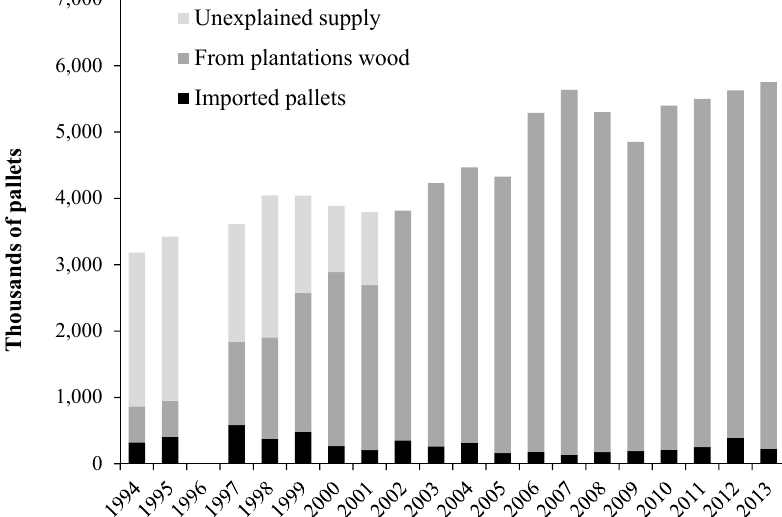
Figure 3. Best guess estimates of the contribution of the different sources of pallets and wood to the total export-based demand, expressed in number of pallets. The unexplained supply corresponds to the wood requirement of the domestic pallet industry that could not have been met by wood supplied from plantations, and thus came from natural forests, agro-forestry systems, and other wood imports.